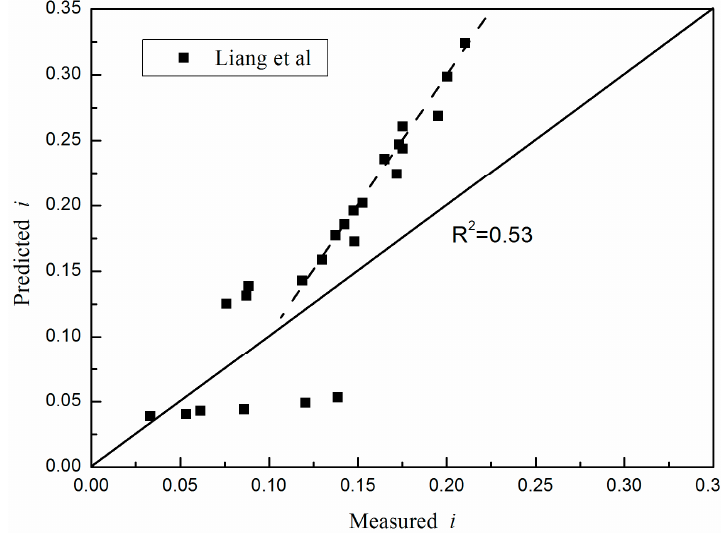
Figure 6. Comparison between predicted and measured data (Liang’s test).